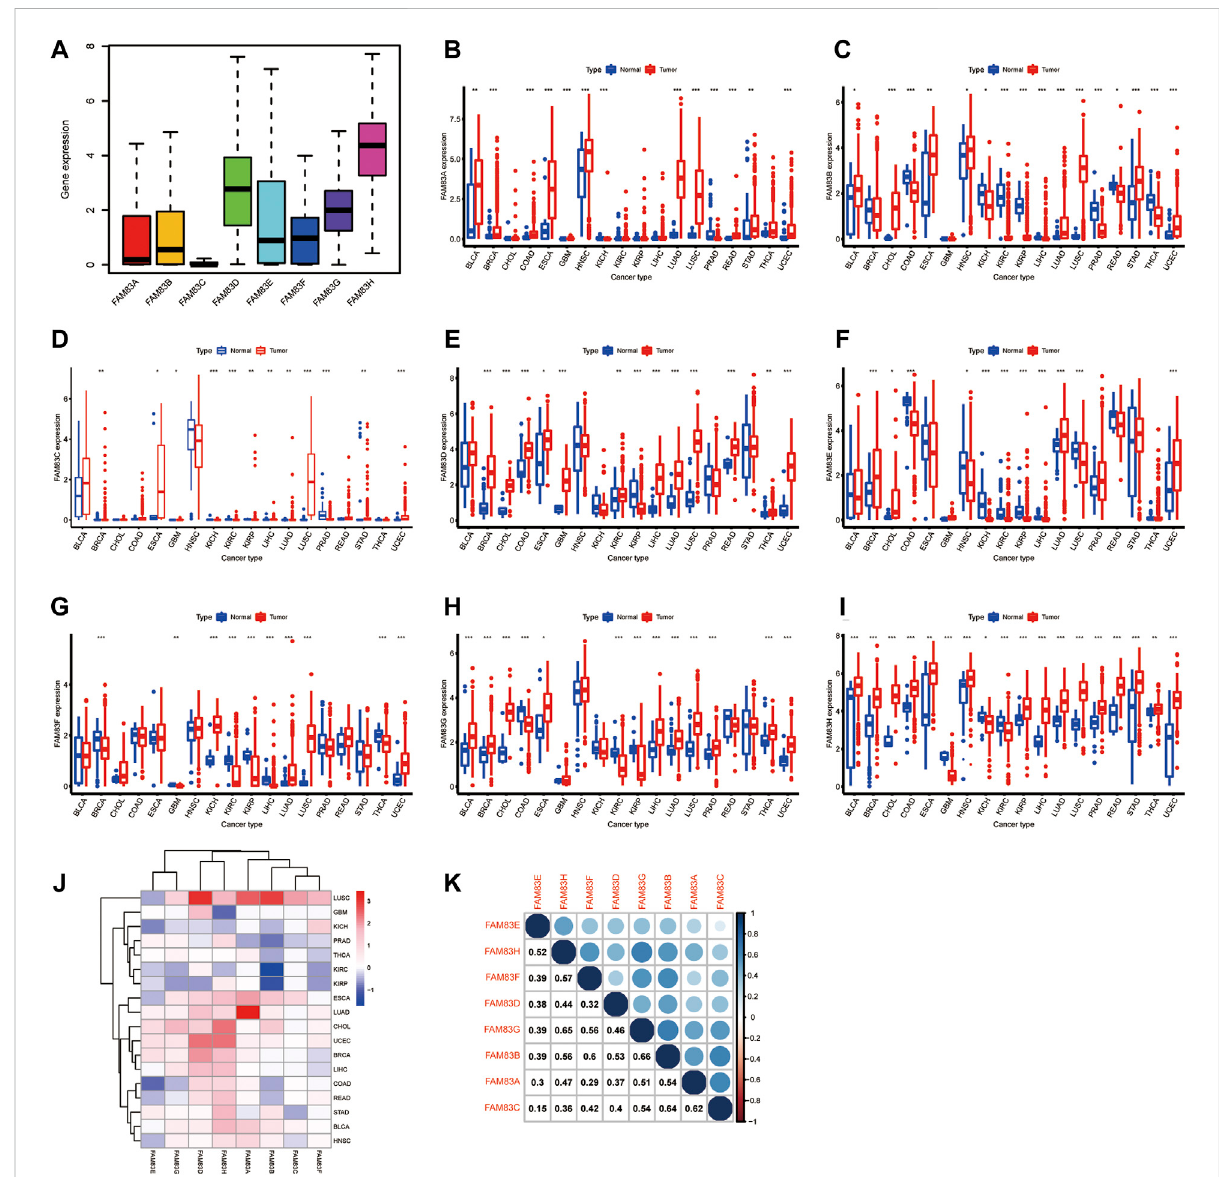
FIGURE 1 Analysis of the differential expression of FAM83 family genes across cancers. (A) Boxplot of the overall transcription level of the FAM83 family genes in 33 tumor types. (B – I) Boxplot of the difference in the expression of FAM83 family genes in carcinoma and normal paracancerous tissue (*** p < 0.001; ** p < 0.01; * p < 0.05). (J) Heatmap of FAM83 family gene expression in carcinoma and normal paracancerous tissues. Red stands for high expression, blue stands for low expression, and color depth indicates the degree of difference. (K) Relevance of expression among FAM83 family genes across